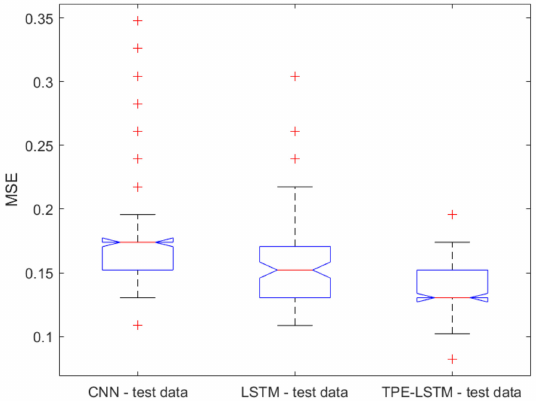
Figure 2. MSE: test data, all runs. CNN, LSTM, and TPE-LSTM.